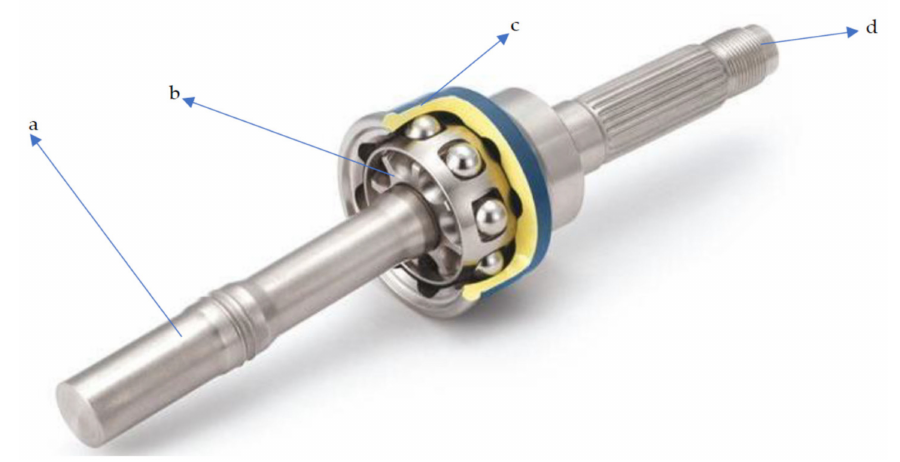
Figure 4. Details of the bowl-inner race (inner race fixed by splines on the midshaft) joint. 2. Computation of the Inertial Characteristics of the AD Elements for the